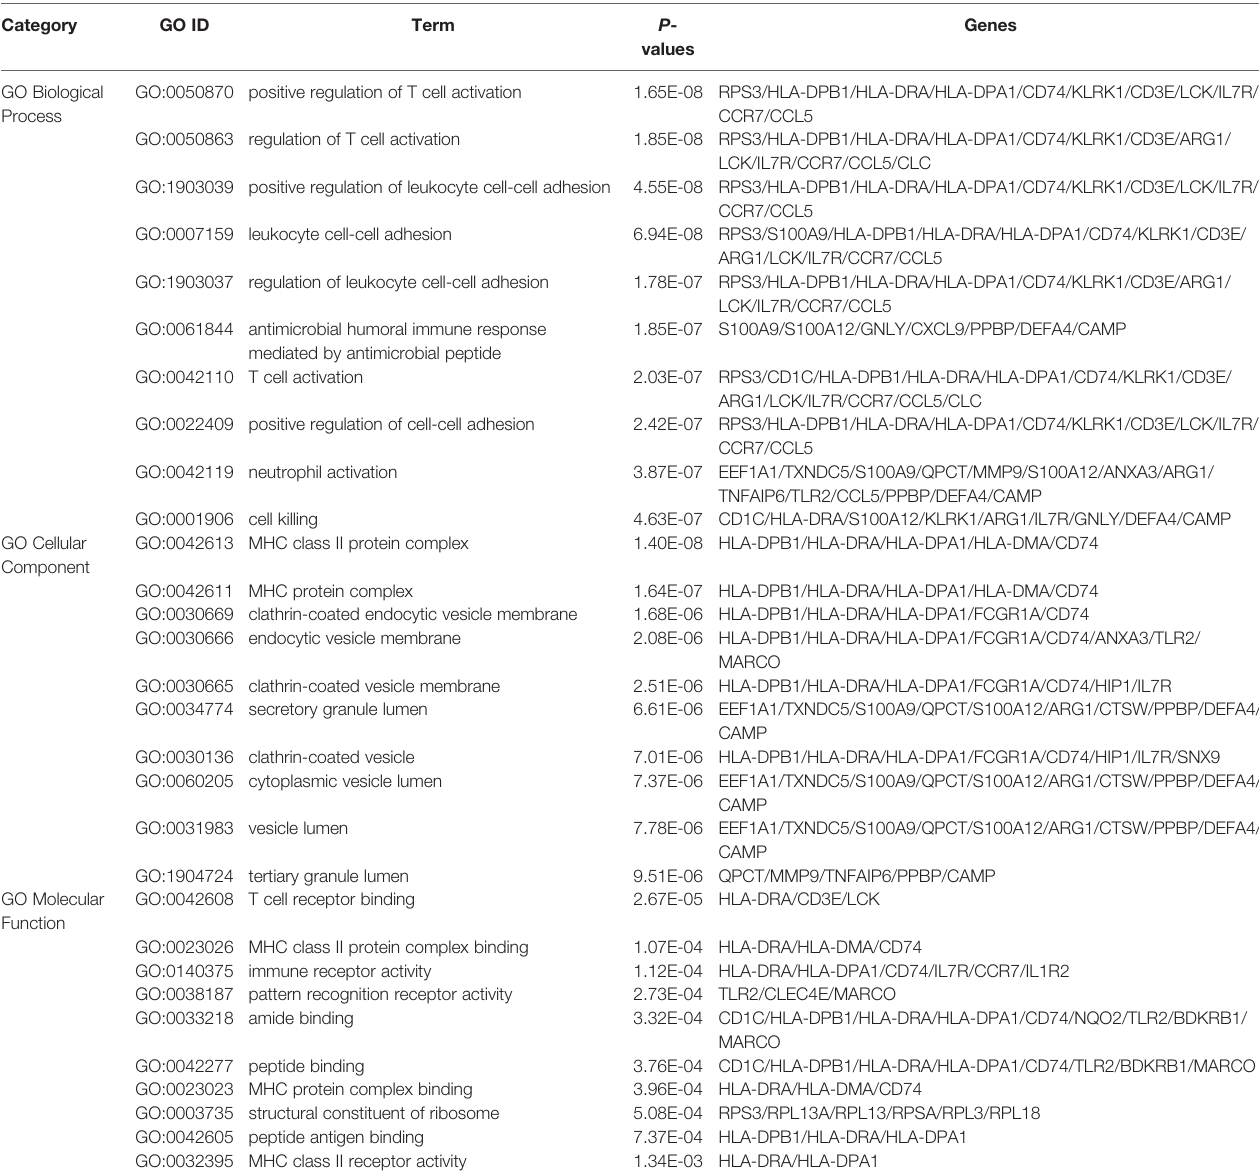
TABLE 2 | Ontological analysis of common DEGs among COVID-19 and RA.